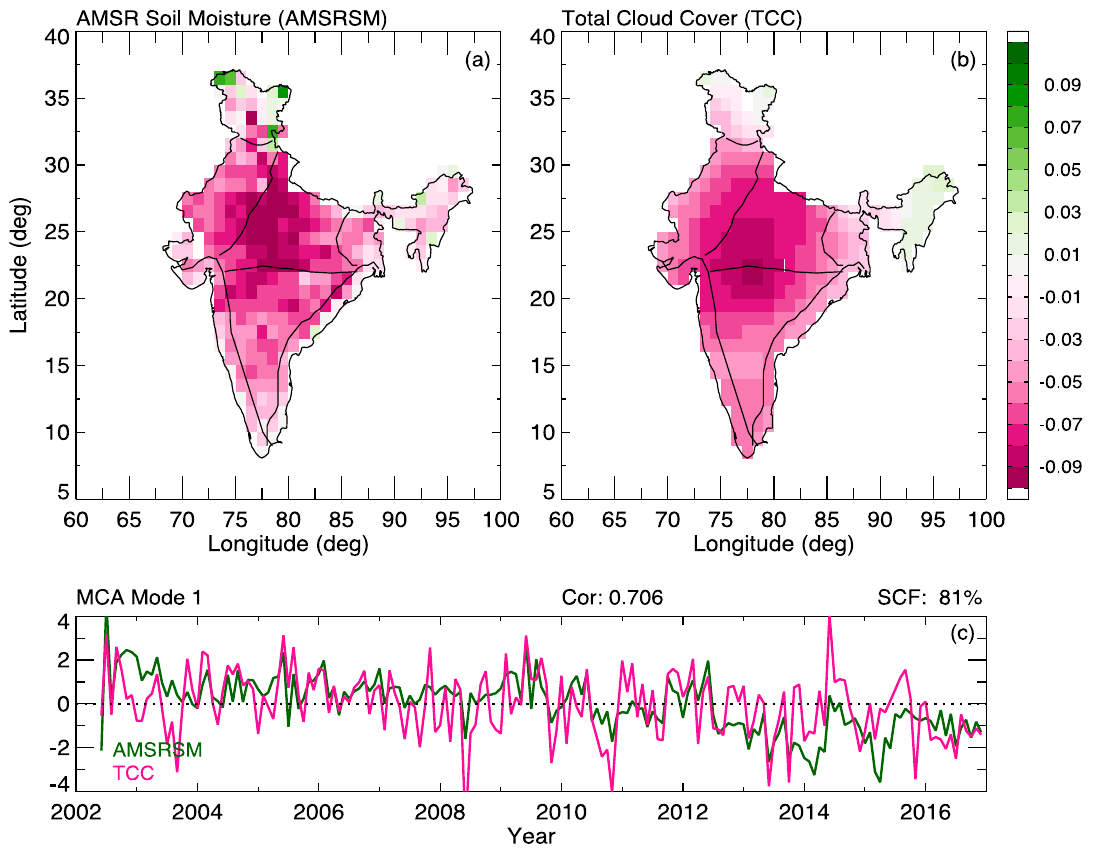
Figure 6. Spatial patterns of the first MCA mode associated with ( a ) AMSR soil moisture and ( b ) total cloud cover (TCC) during the period 2006–2016. ( c ) The corresponding covariance coefficients associated with AMSR soil moisture (green curve) and TCC (pink curve). The squared coefficient factor (SCF) and correlation coefficients are indicated on the top of the plot.